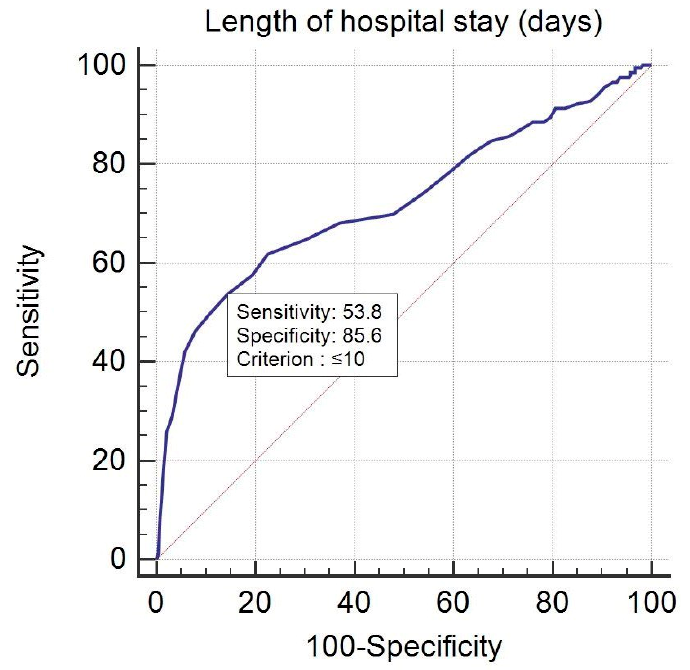
Figure 3. ROC curve analysis for the length of hospital stays.